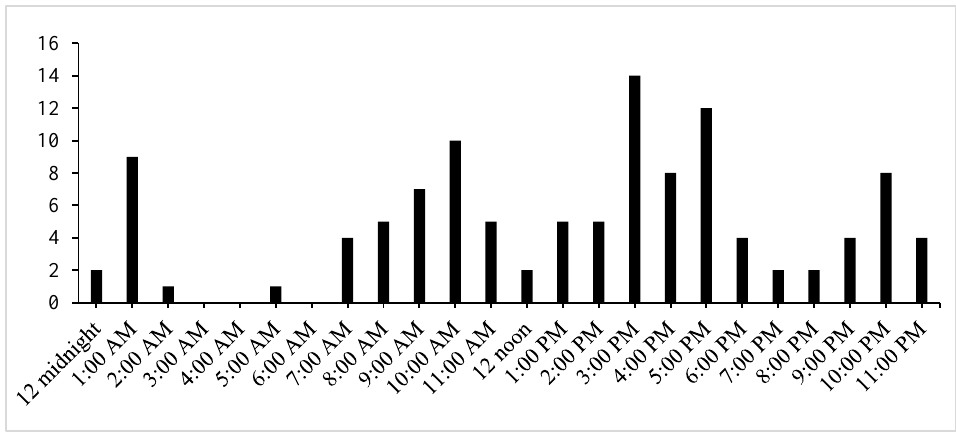
Figure 3. Participants’ usage and time points of using the e -painting app.